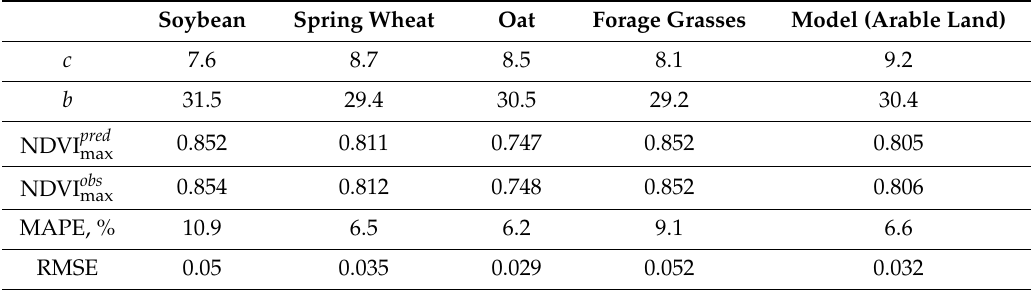
Table 3. Parameters of the NDVI seasonal variation curves, the maximum NDVI values, and the errors for crops grown in the experimental fields in the Khabarovsk District in 2018.